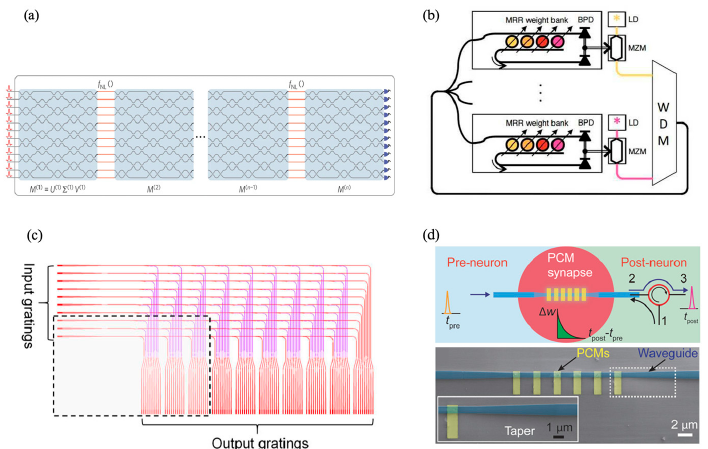
Figure 1. Implementing a neural network based on silicon integration. ( a ) A silicon photonic inte- grated circuit comprising programmable MZIs realizes the optical interference unit. This architecture enables the operation of the weight matrix using the MZIs through singular value decomposition [33]. ( b ) Using the micro-ring resonator as the neuron of the broadcast and weight network, the wavelength division multiplexed signals are weighted using reconfigurable continuous value filters and then summed for total power detection [40]. ( c ) A biplane signal distribution network is realized through the stacking of waveguides, which can complete the all-around connection of the feedfor- ward neural network [41]. ( d ) Photonic synapses are fabricated using PCM in combination with an integrated silicon nitride waveguide, and the synaptic weights are set randomly by varying the number of optical pulses sent by the waveguide [43].